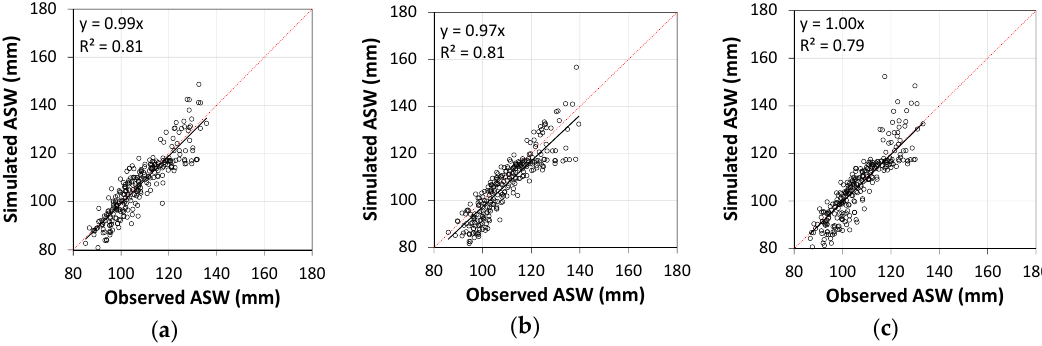
Figure 3. Simulated vs. observed available soil water (ASW) relative to the validation of SIMDualKc model for treatments of CGDD of: ( a ) 124 °C, ( b ) 248 °C and ( c ) 372 °C. Errors of estimation are small (Table 6). On the one hand, the RMSE range from 4.2–5.2 mm at calibration and 5.0–7.2 mm at validation, corresponding to NRMSE in the range of 4.0–6.7% of observed ASW, as well as ARE also ranging from 3.2–5.2%, thus indicating good accuracy of model simulations. On the other hand, EF values were quite high for the calibration cases (0.76–0.86) and reasonably good for the validation simulations, which ranged from 0.42–0.79, therefore indicating that the variances of the residuals of estimation were much smaller than the variance of observations. Overall, the goodness of fit indicators point to the appropriateness of using SIMDualKc to simulate the soil water balance of Tifton 85 bermudagrass adopting the obtained calibrated parameters and, in particular, the adequacy of adopting a K cb curve consisting of successive individual cutting K cb lines designed with the respective K cb ini , K cb gro and K cb cut . Table 6. Goodness-of-fit indicators relative to both the calibration and validation of all treatments.